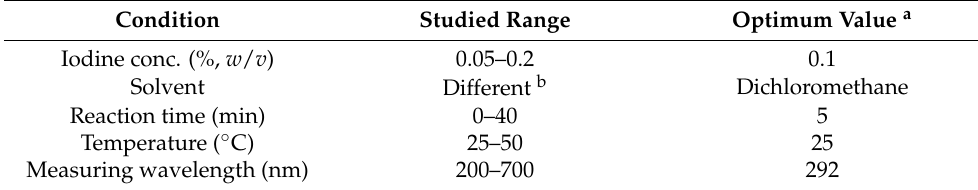
Figure 7. The effect of iodine concentration on its reaction with TKIs (25 µ g mL − 1 ). Table 5. Optimization of experimental conditions for the MW-SPA for TKIs based on their CT reaction with iodine.